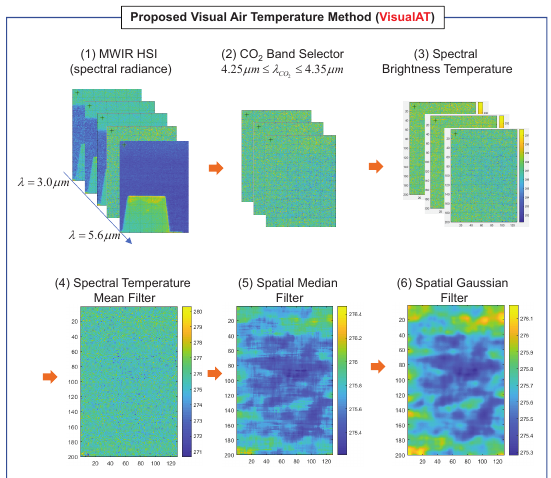
Figure 9. Overall processing flow of visual air temperature (VisualAT) measurement